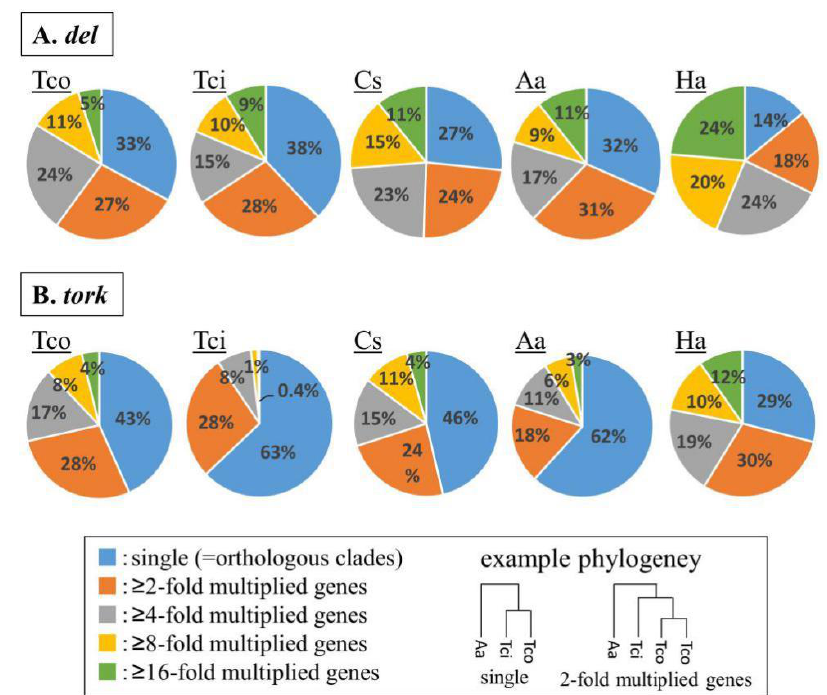
Figure 3. Multiplication analysis of ( A ) del- clade and ( B ) tork- clade transposable elements (TEs). Based on the molecular phylogenetic trees for del TEs and tork Tes, the number of co-clustered genes in single-genus clusters, which reflects the inferred number of genus-specific duplication events, were counted for each genus. Tco: T. coccineum ; Tci: T. cinerariifolium ; Cs: C. seticuspe ; Aa: A. annua ; Ha: H. annuus.